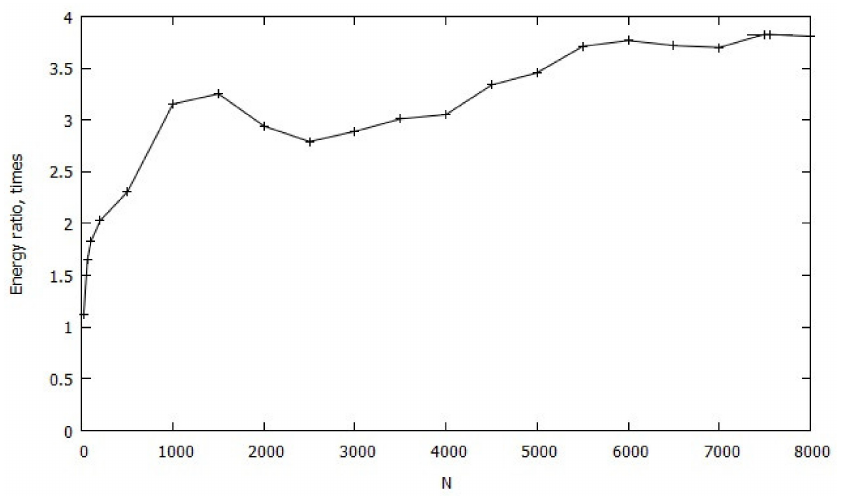
Figure 11. The ratio of the energy consumption of the basic and single-pass transformation